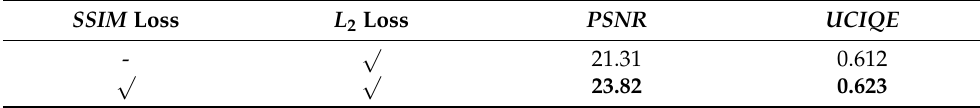
Table 6. Verification of SSIM loss component.